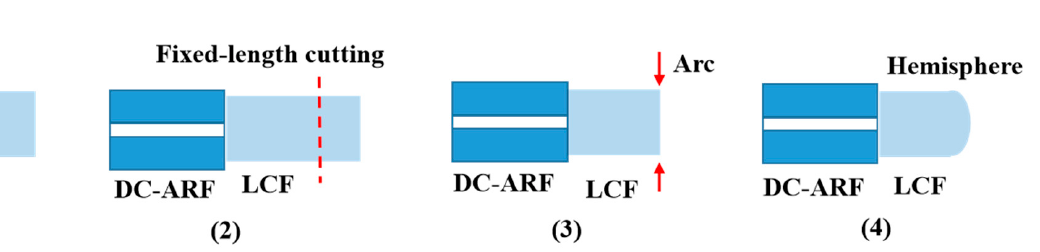
Figure 4. The fabrication process of lensed fi ber.